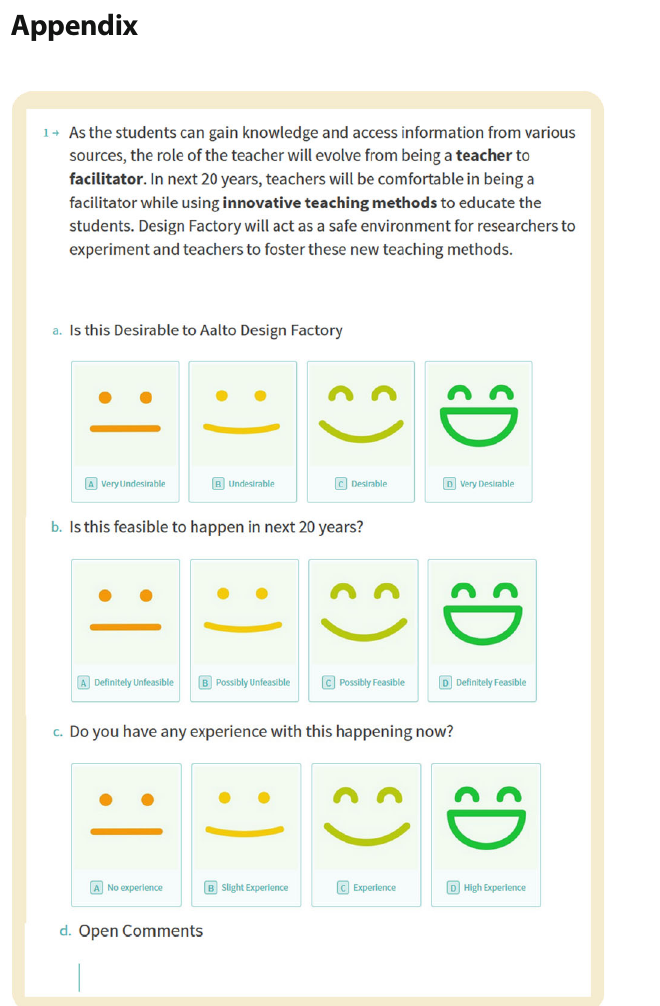
Fig. 7 Online survey question and scale